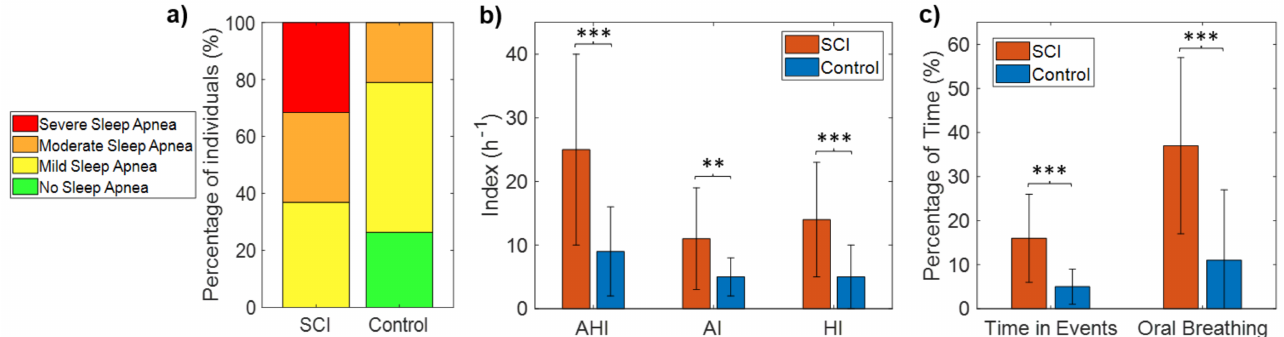
Figure 3. Number of subjects in each category of sleep apnea severity for the SCI and control groups ( a ), mean and SD of AHI, AI, and HI in each group ( b ), and mean and SD of the percentage of time spent during events and the percentage of oral breathing in each group ( c ). Statistically significant differences are indicated with asterisks: ** p < 0.01, and *** p <